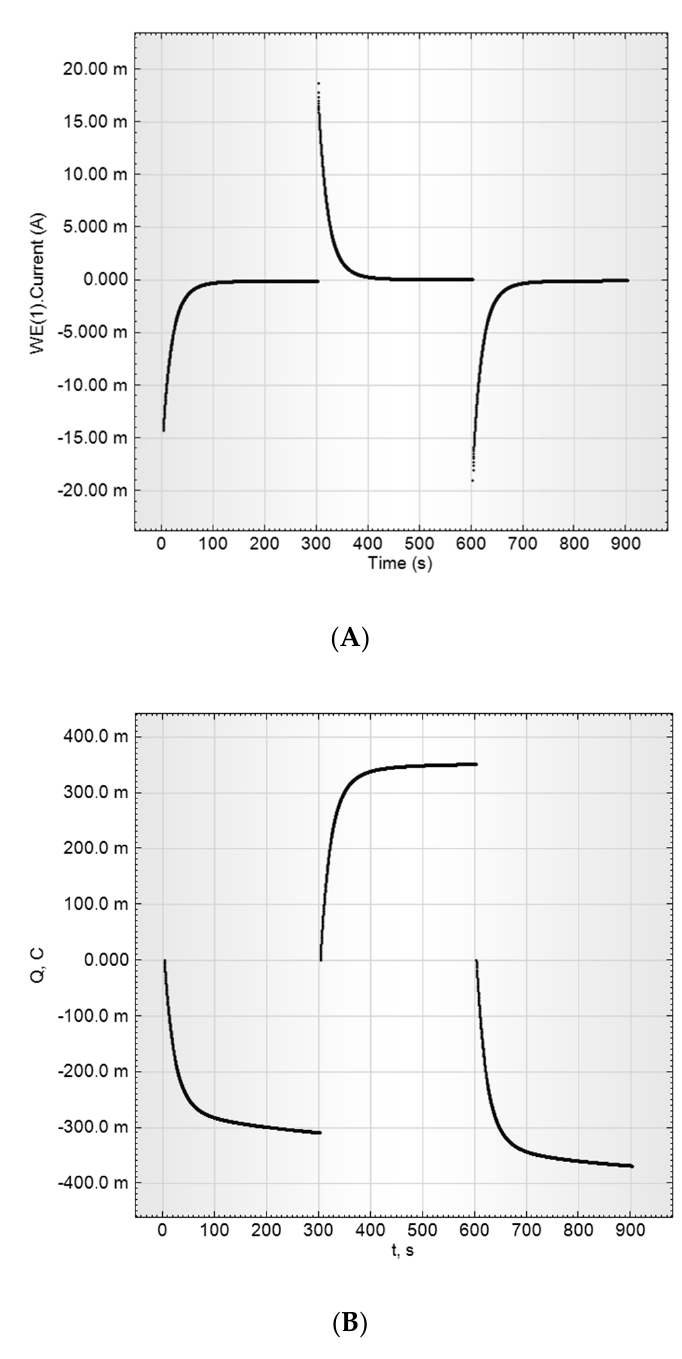
Figure 8. The charge-discharge curves of RF-1000 sample (15 mg) in a 2M aqueous sulfuric acid solution. ( A ) is the charging current vs. time I (t), ( B ) is the current integral, that is, the charge of the supercapacitor, Q (t).